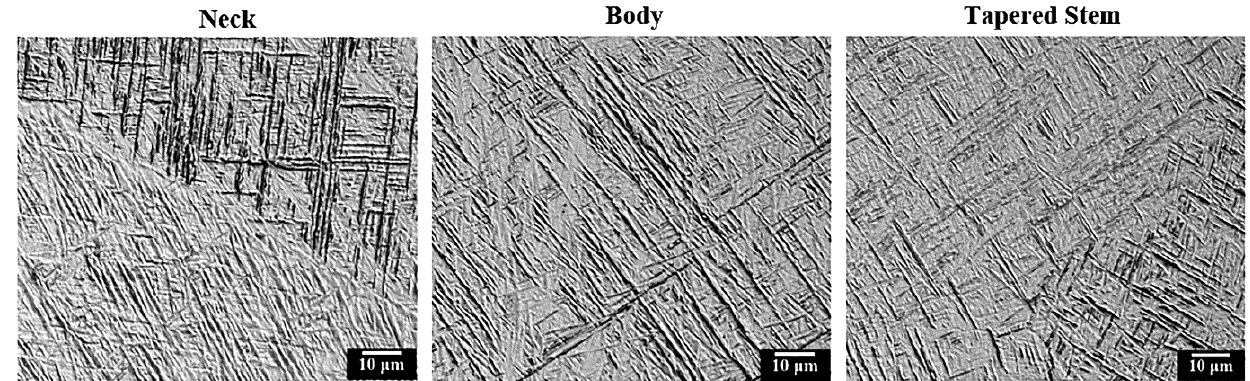
Figure 9. Digital micrograph of the martensite at the different locations of the DPF femoral stem.